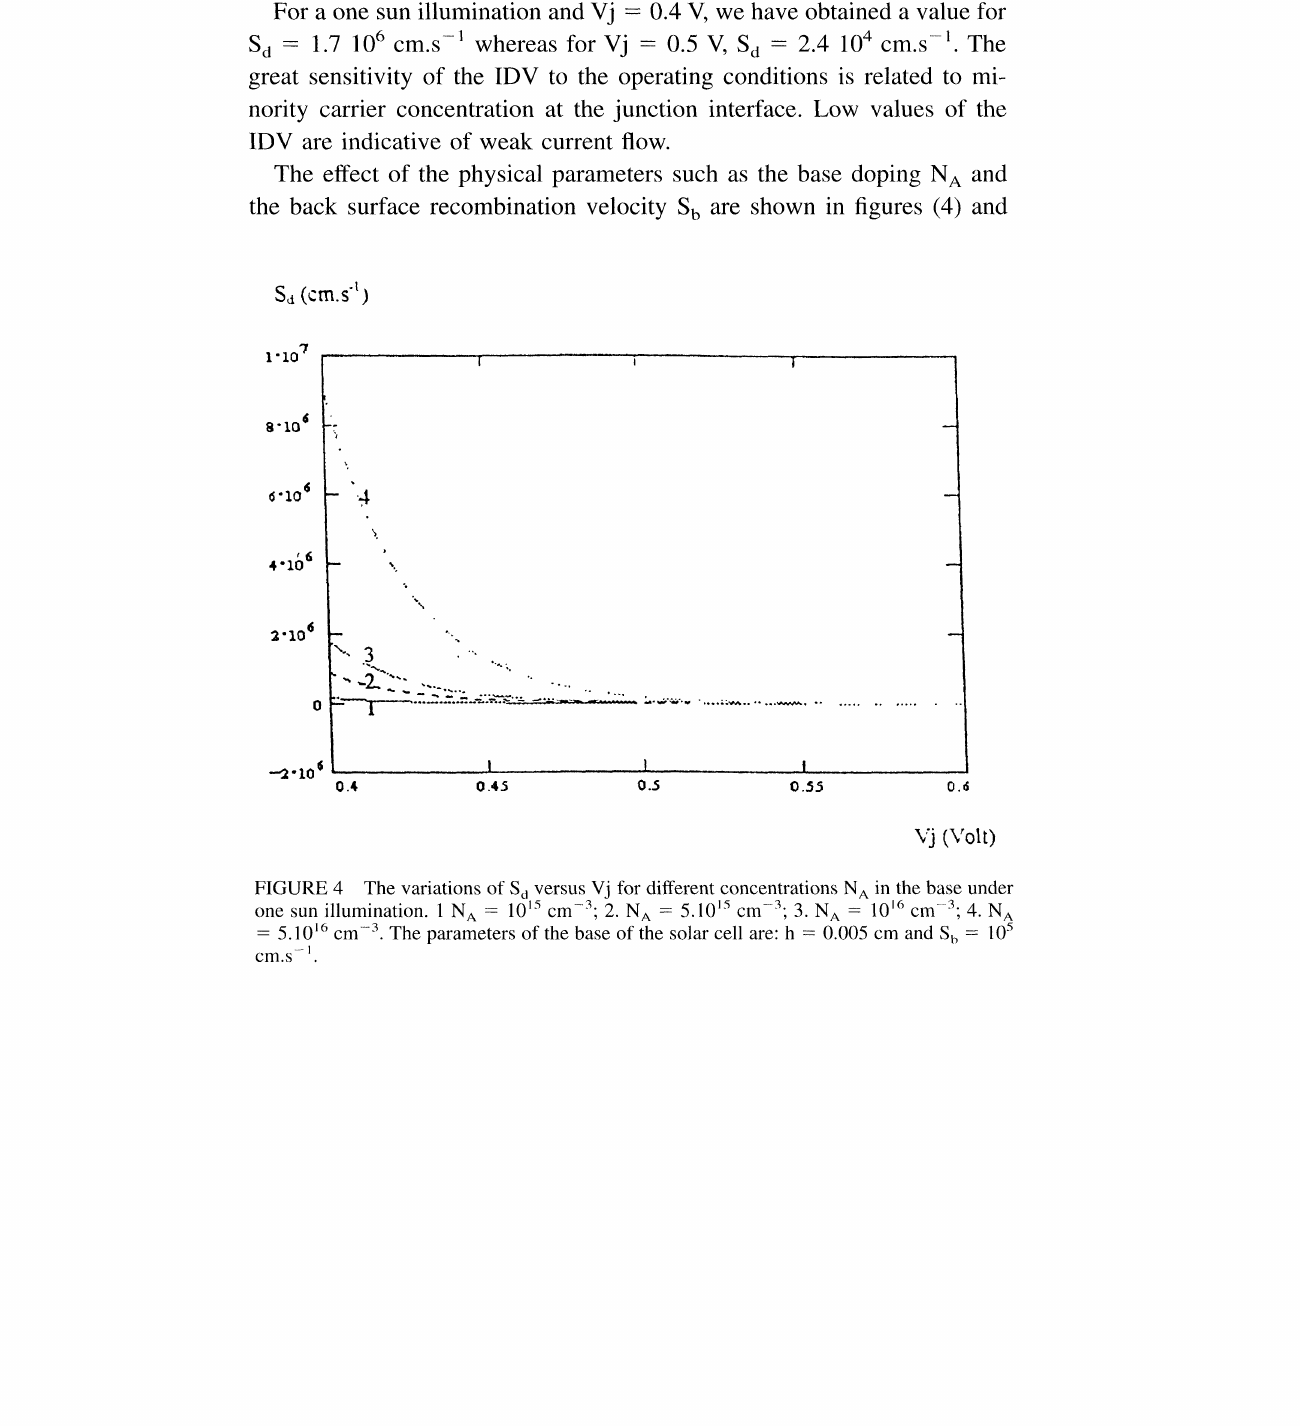
FIGURE 4 The variations of S,t versus Vj for different concentrations N one sun illumination NA 10 ls cm -" 2. N A 5.1015 cm-3; 3. N A 1016 cm --3" 4. N A 51016 cm -3. The parameters of the base of the solar cell are: